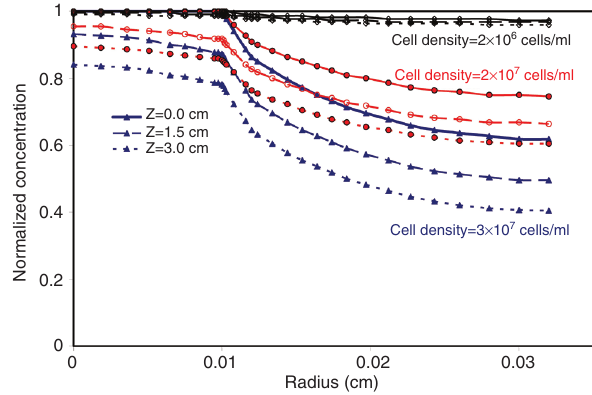
Figure 12 Normalized oxygen concentration distribution in the scaffold from the finite element simulations for different cell densities [49].